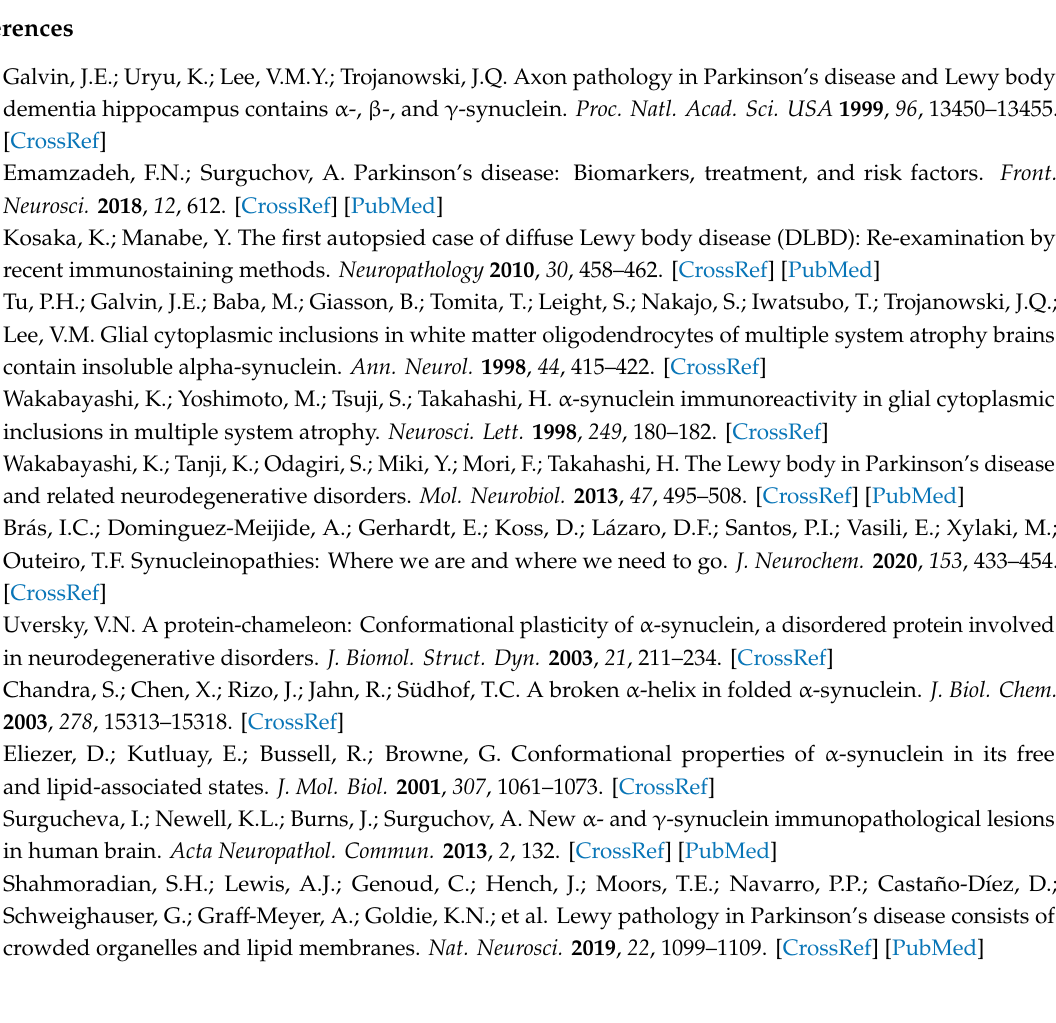
Figure S1. Multiple sequence alignment with predicted local (secondary) structures; Figure S2. Comparison of the CD spectra obtained for human PREPL, human and porcine POP; Figure S3, Adjusted sensorgrams obtained in the SPR assays with PREPL or POP immobilized and α -Syn as the analyte injected at increasing